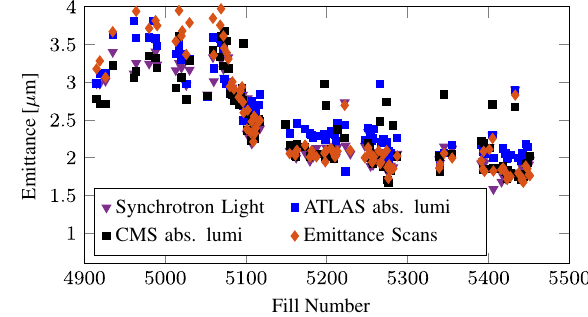
FIG. 9. The average convoluted emittances at the start of collisions in 2016 proton physics